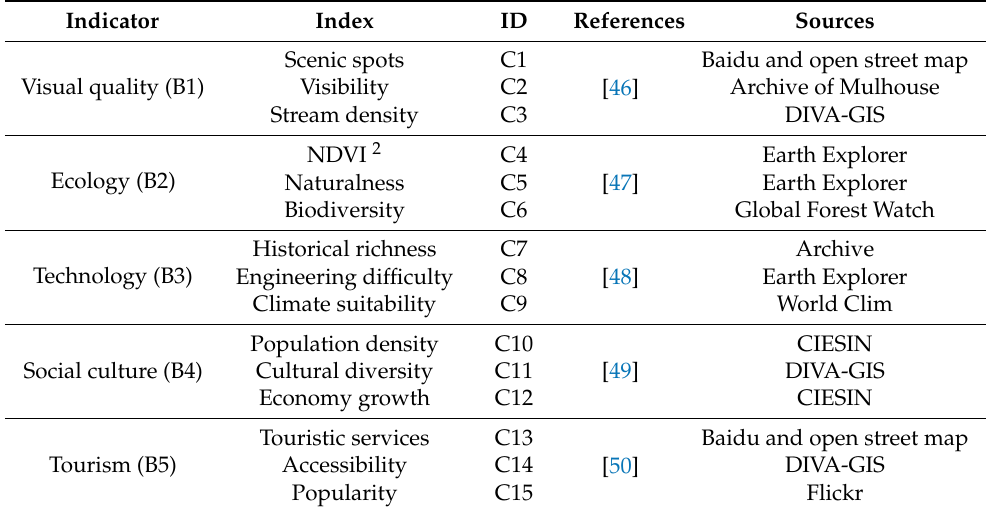
Table 2. Railway landscape evaluation